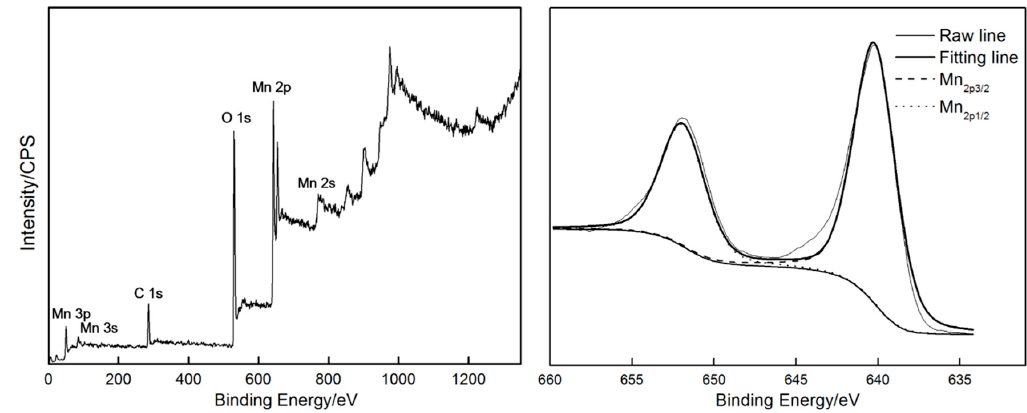
Figure 9. The survey and Mn 2p XPS spectrum of the product after depositing for 120 s.